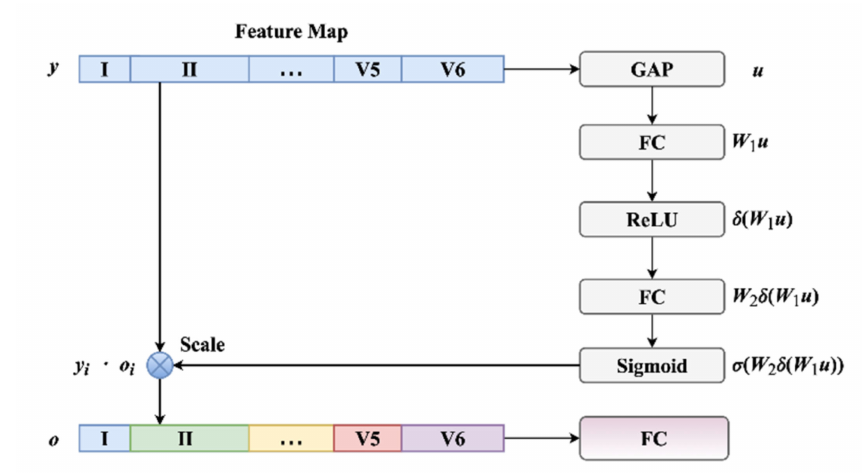
Figure 6. The operations of an LSE block.